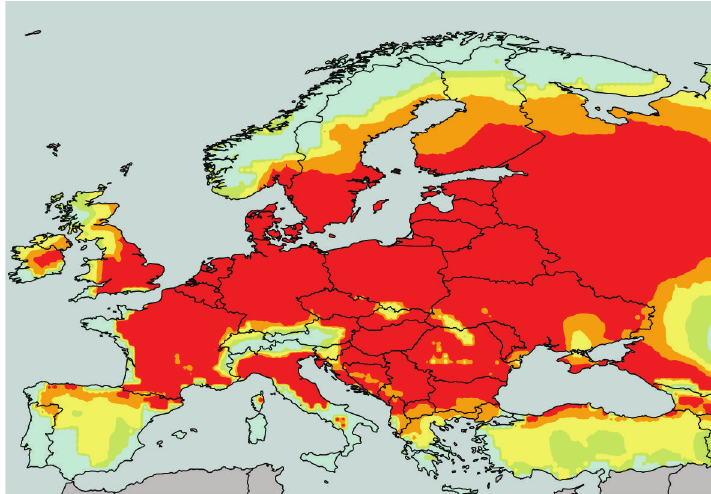
Figure 1: Potential distribution and relative abundance of Sitona lineatus in Europe as predicted by CLIMEX. Light blue: “Unfavourable” (EI = 0–5); Green: “Marginal” (EI = 5–10); Yellow: “Suitable” (EI = 10–15); Tan: “Favourable” (EI = 15–20); Red: “Very Favourable” (EI > 20).